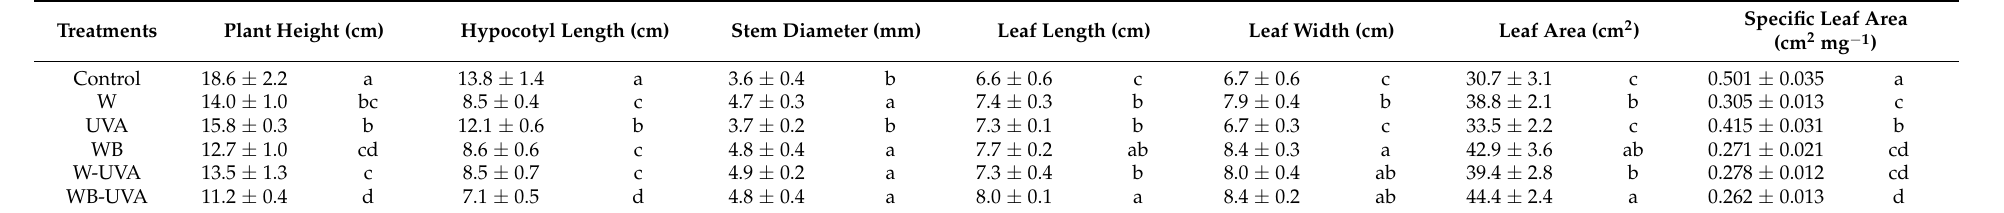
Table 1. Morphological performances of greenhouse-grown cucumber seedlings cultivated under supplementary light provided by white (W), UV-A light-emitting diodes (LEDs), and various combinations of W, blue (B), and UV-A LEDs; cucumber seedlings grown without supplementary light were used as control.